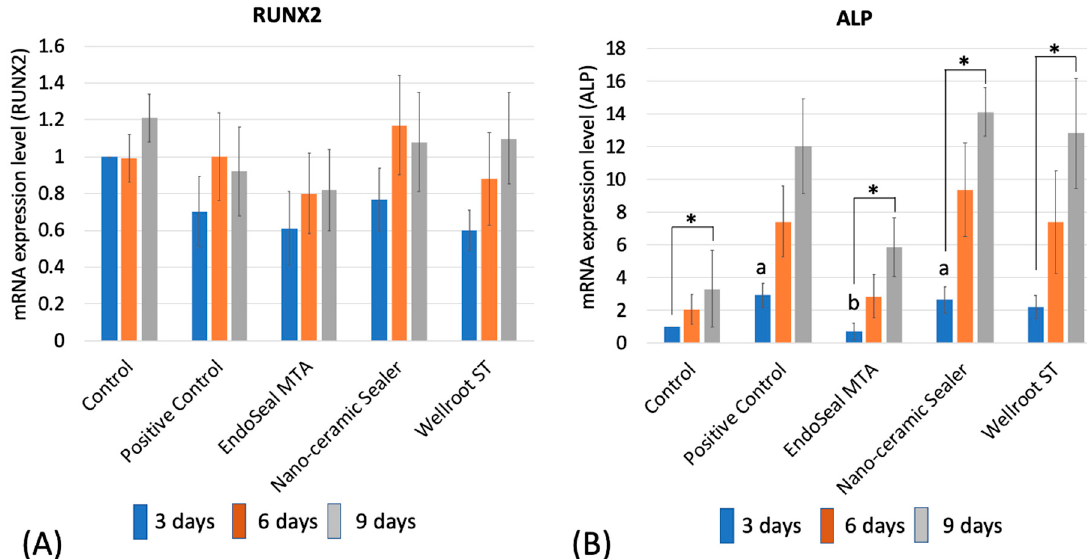
Figure 7. The effects of sealers on the mRNA expression of ( A ) RUNX2 and ( B ) alkaline phosphatase (ALP) by real time qPCR for 9 days ( a , b mean significant difference between groups connected by bar. * means significant difference between time periods. p < 0.05). Three calcium silicate-based sealers showed no significant difference with control and positive control on RUNX2 expression. All of the Nano-ceramic Sealer, EndoSeal MTA, and Wellroot ST showed significantly higher ALP expression on 9 days than on 3 days.